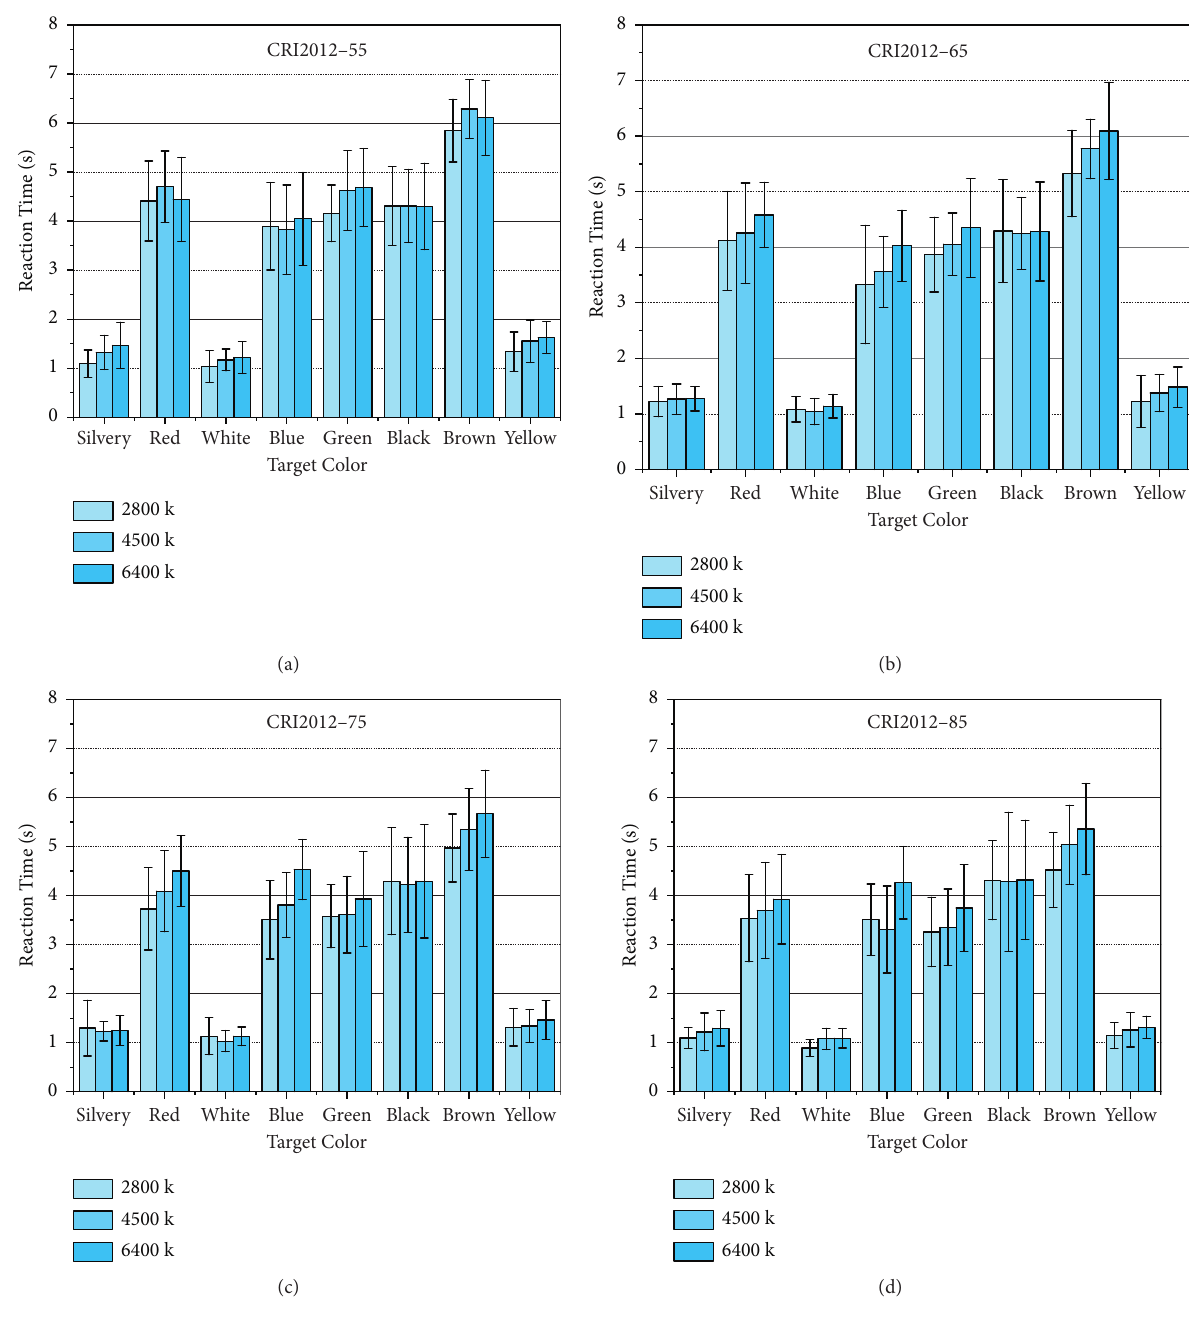
Figure 16: The reaction time of all observers under different CRI2012s and